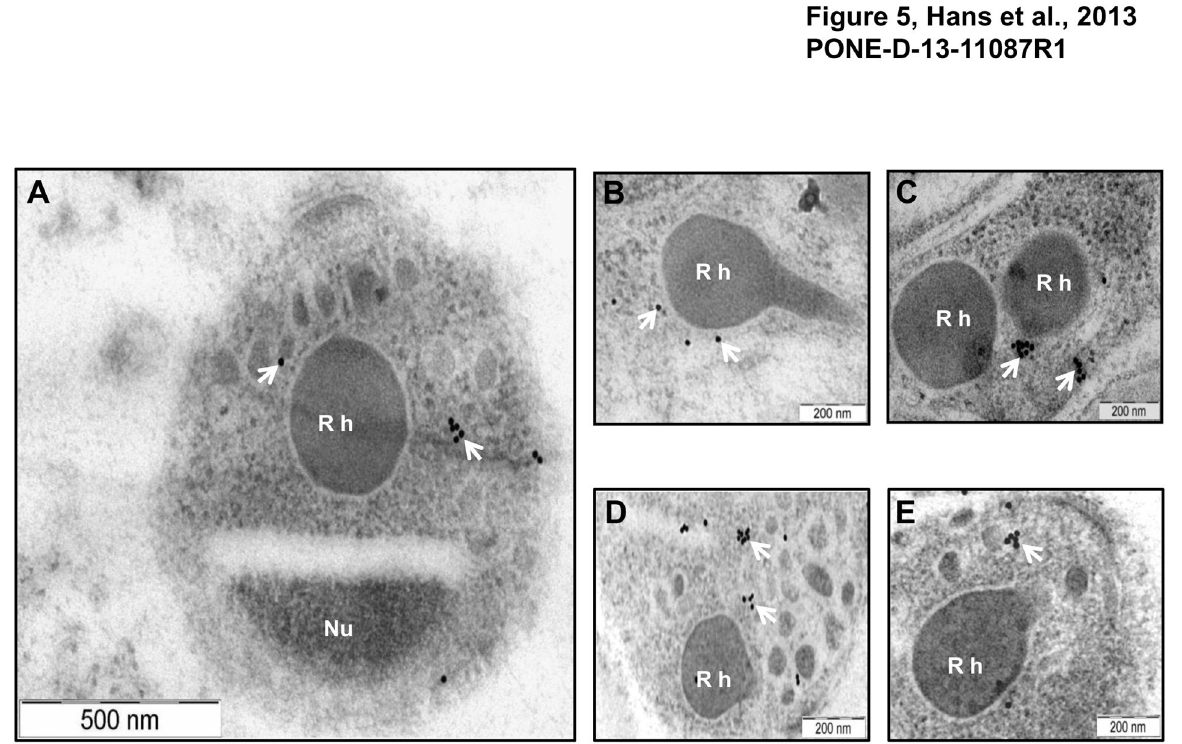
Figure 5. Localization of PfMA by Immuno-electron microscopy. Ultra thin sections of P. falciparum parasites at schizont/ merozoite stages were labelled with mouse anti-PfMA or anti-EBA-175 antibodies followed with anti-mouse secondary antibody conjugated with 15nm colloidal gold particle. ( A ) Labelling with the PfMA antibody was confined only to the micronemes (arrows) in the apical end of the free merozoite and was absent from the rhoptry (Rh) or nucleus (Nu). ( B , C ) Similarly PfMA staining in the schizonts was observed only in the micronemes and not in the rhoptries. ( D , E ) A similar pattern of staining in the schizonts was observed with the micronemal marker EBA-175. doi: